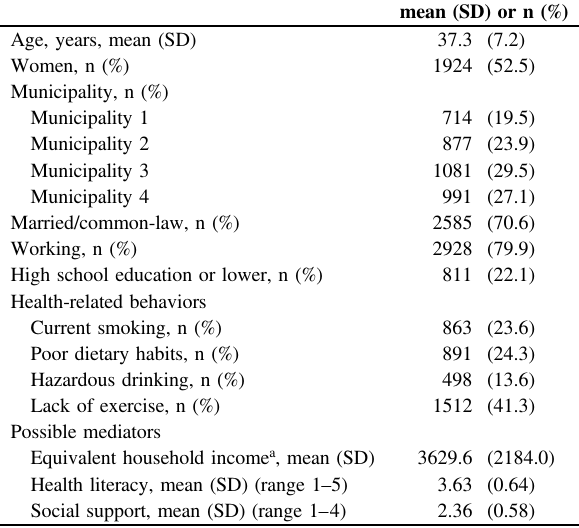
Table 1 Characteristics of participants aged 25 – 50 years residing